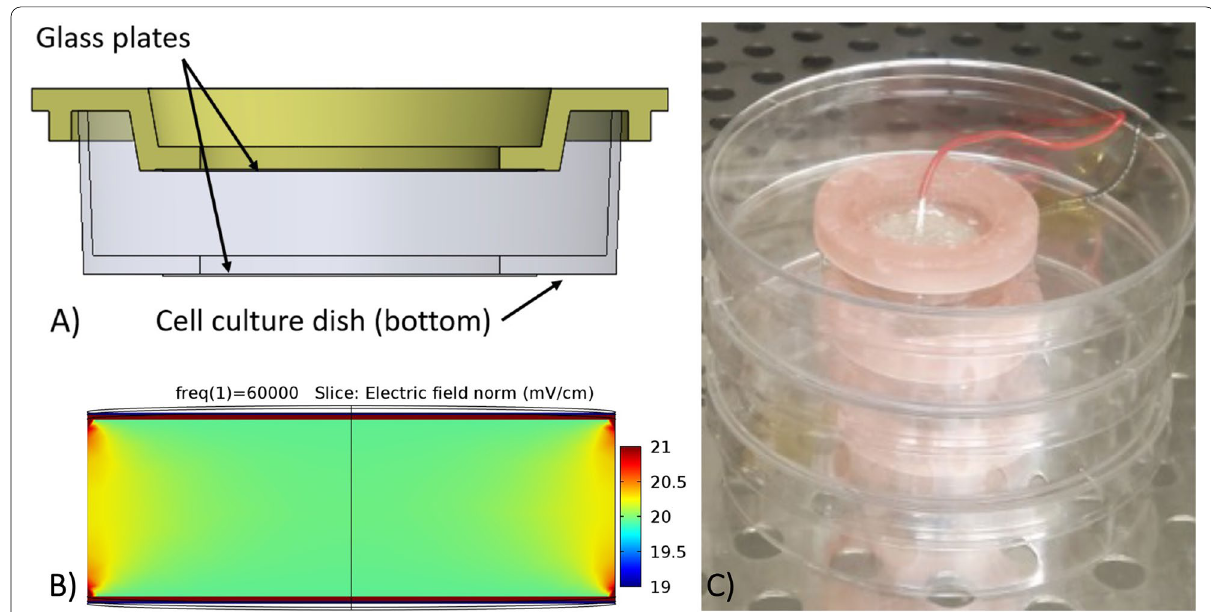
Fig. 1 Experimental Apparatus. A A CAD rendering of the fabricated in‑vitro exposure apparatus consisting of a cell culture dish and a custom lid with integrated glass coverslips to serve as the dielectric for capacitive stimulation. B Cross‑section of the FEA model of the electric field generated within the in‑vitro exposure apparatus. The field uniformity is within 5% of the desired value of 20 mV/cm in all regions within the dish. C A stack of manufactured culture dishes within an incubator showing the attached wires used to deliver the